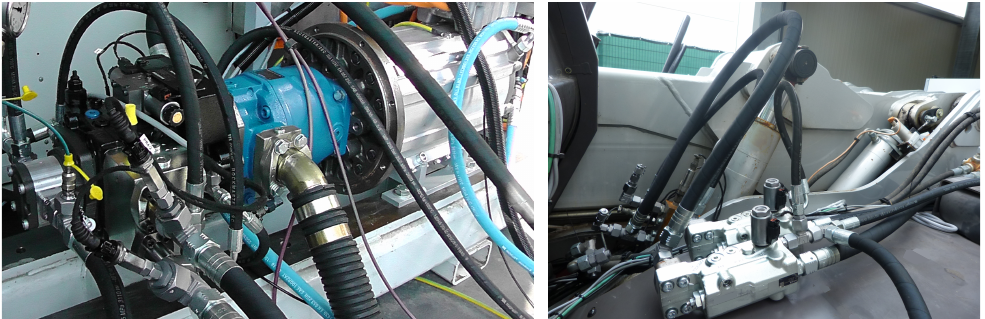
Figure 3. Added hydraulic components— Left : (in the order from left to right) charge pump, closed- circuit pump for boom control in black with valve block attached, and open-circuit LS pump in blue— Right : load-holding valves for left boom cylinder, connected to rod and piston side via short hoses (visible on the right side of the boom cylinder is the compensation cylinder, which is connected to the tilt cylinder for parallel movement of the